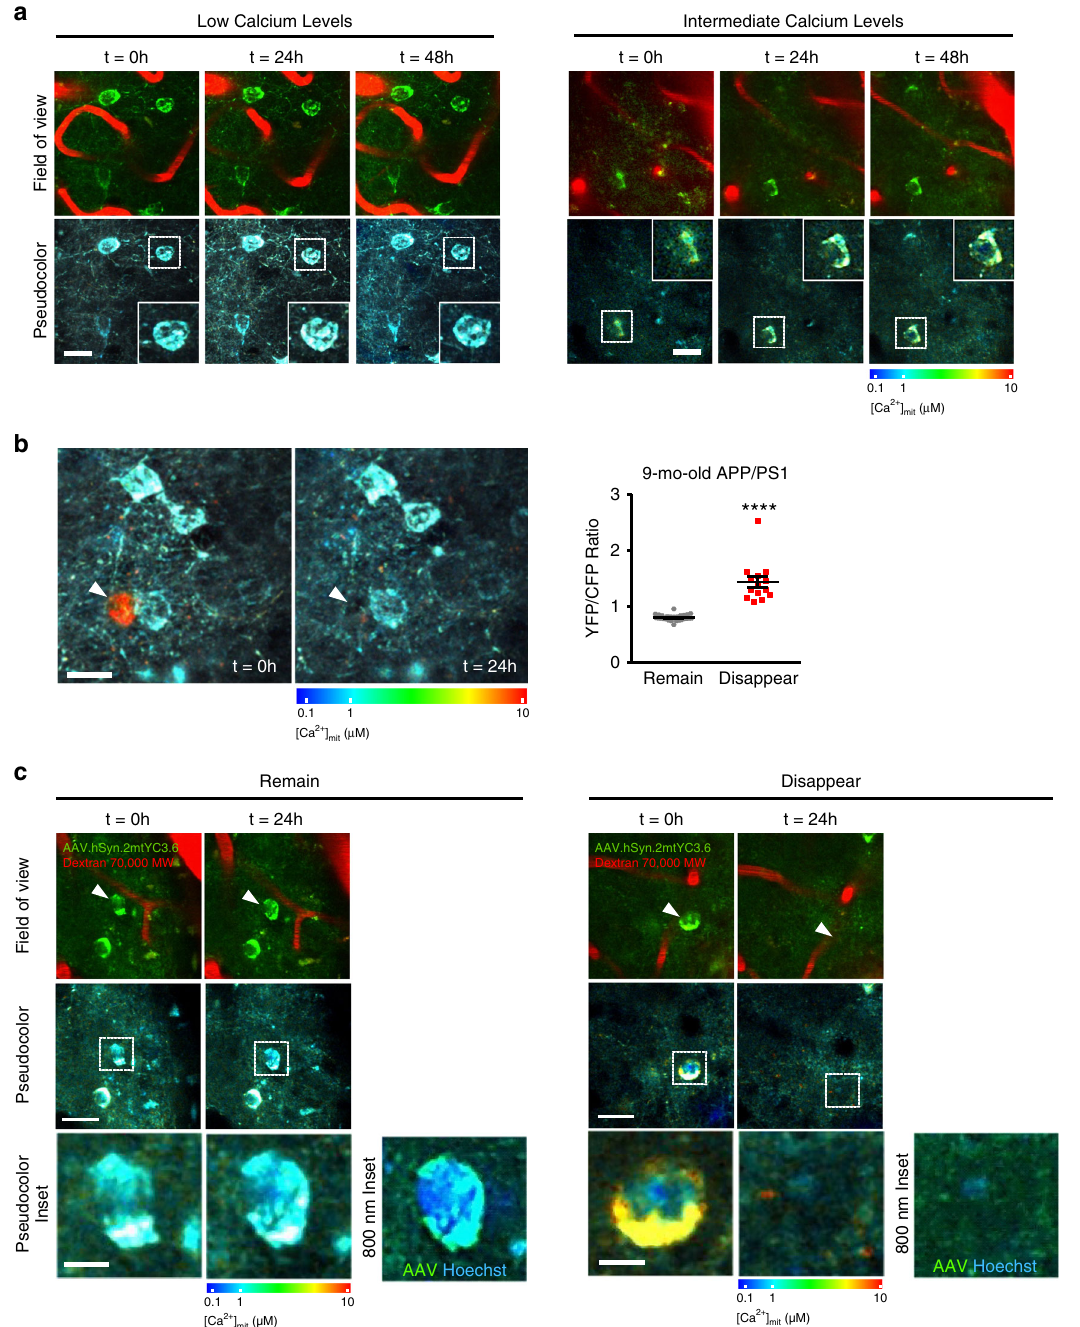
Fig. 7 Mitochondrial Ca 2 + overload precedes neuronal death in the APP/PS1 Tg mice. a Time-lapse images showing that resting mitochondrial Ca 2 + levels in neurons are steady over time in the 9-mo-old APP/PS1 Tg mouse. The same fi eld of view was imaged at 3 different time points (3 consecutive days). AAV.hSyn.2mtYC3.6 (neurons, green) and Dextran Texas Red (vessels) are shown in the top row and pseudocolor images in the bottom row. Insets show somas of the same neuron during the time lapse. Scale bar 25 µ m. b Time-lapse images showing mitochondrial Ca 2 + overload preceding neuronal cell death in a 9-mo-old APP/PS1 Tg mouse. Arrow heads show mitochondrial Ca 2 + overload in the soma of a neuron, which disappeared 24 h later. Scale bar 20 µ m. Scatter dot plot represents YFP/CFP ratio of single neurons present at baseline imaging session that remained or disappeared at 24 h follow-up imaging session as a function of their baseline [Ca 2 + ] mit . Neurons with a YFP/CFP ratio >1.4 disappeared within 24 h (mean ± SEM, n = 27 and 14 neurons from 4 APP/PS1 mice, **** p < 0.0001, Student t -test). c Images show time-lapse recordings of nuclei and mitochondrial Ca 2 + levels preceding neuronal cell death in a 9-mo-old APP/PS1 Tg mouse. The same fi eld of view was imaged at 2 different time points (2 consecutive days). AAV.hSyn.2mtYC3.6 (neurons, green) and Dextran Texas Red (vessels) are shown in the top row, and pseudocolor images are shown in the middle (scale bar 20 µ m) and bottom (scale bar 5 µ m) rows. 800 nm inset shows AVV (mitochondria, green) and Hoescht (nuclei, blue) acquired at 800 nm. It was observed that remaining cells (low mitochondrial Ca 2 + ) maintained a healthy nucleus (Hoechst), whereas disappearing cells (high mitochondrial Ca 2 + ) presented a condensed